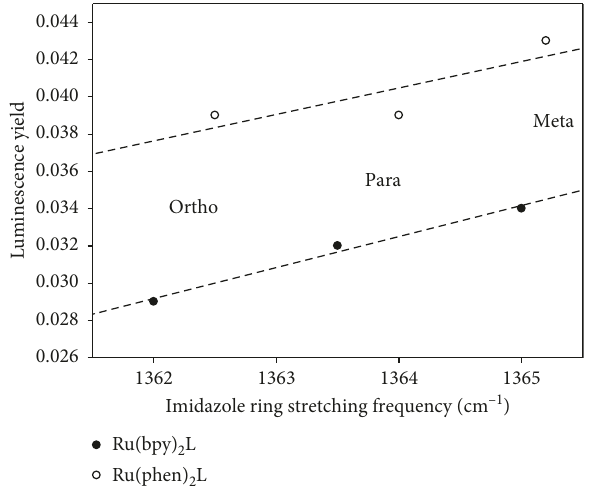
Figure 10: Luminescence yield against imidazole ring stretch for the positionally substituted